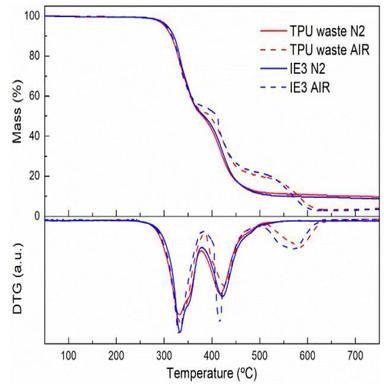
Weight loss (up) and DTG (down) curves obtained for the TPU waste and IE3 sample.